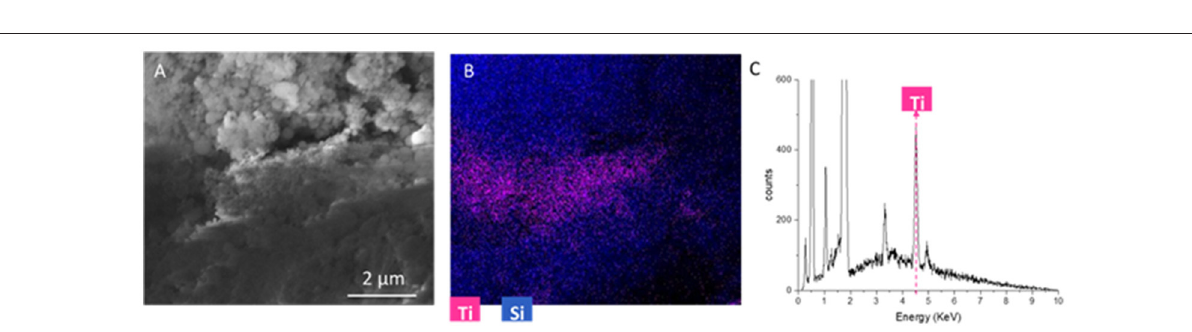
Frontiers in Chemistry |